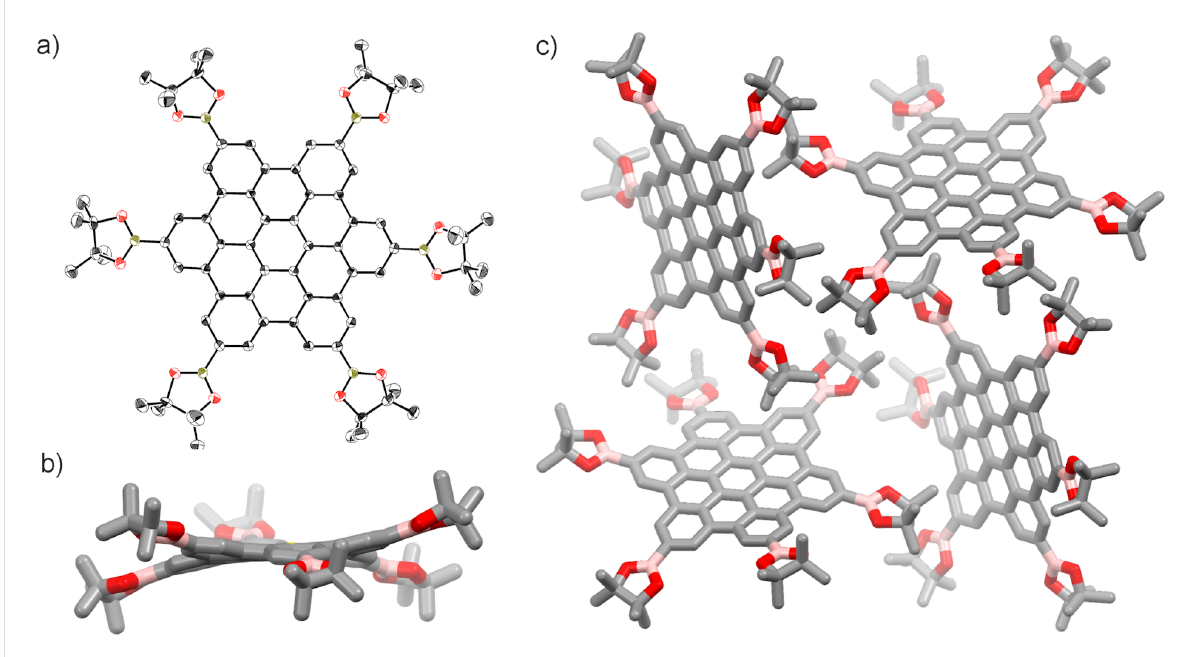
Figure 3: The structure of 1 confirmed by X-ray crystallographic analysis. (a) ORTEP drawing of 1 with thermal ellipsoids set to 50% probability; all hydrogen atoms and solvent molecules (pentane) are omitted for clarity; gray: carbon; olive green: boron; red: oxygen. (b) Side view of 1 . (c) Packing mode of 1 .